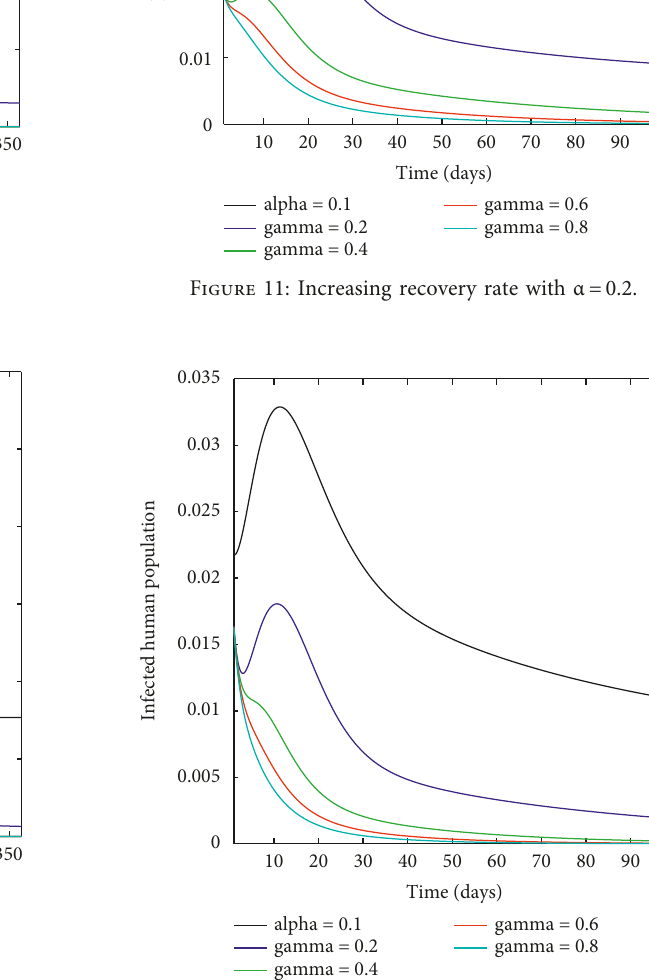
Figure 10: c � 0 . 25 for the infected vectors.